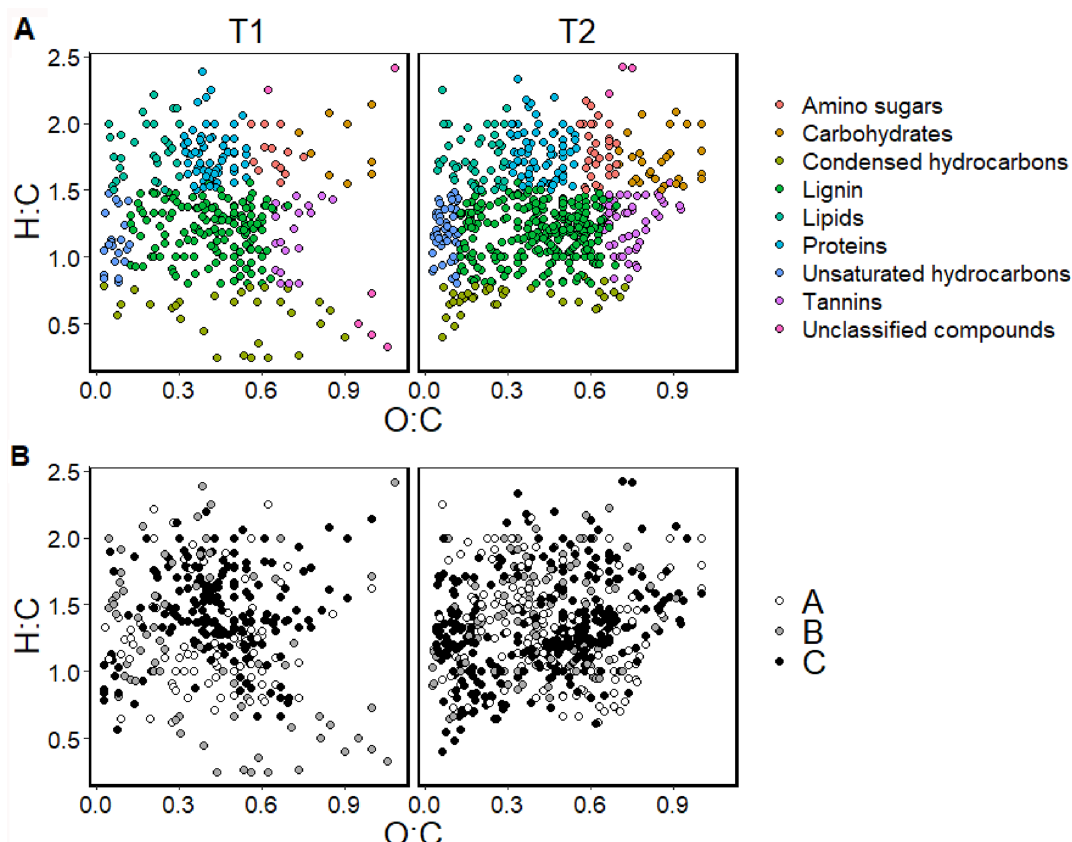
Figure 6. Root exudate composition increased from T1 (before treatment) to T2 (after treatment) ( A ), and shifted among treatments A (control), B (mild), and C (severe) between T1 and T2 ( B ). Van Krevelen plots of FTICR-detected compounds at T1 and T2 colored by compound class ( A ) and treatment ( B ). Van Krevelen plots depict the elemental ratios of O:C and H:C of compounds on the x and y axes, respectively, and are used to group compounds into high-level chemical classes 120,121